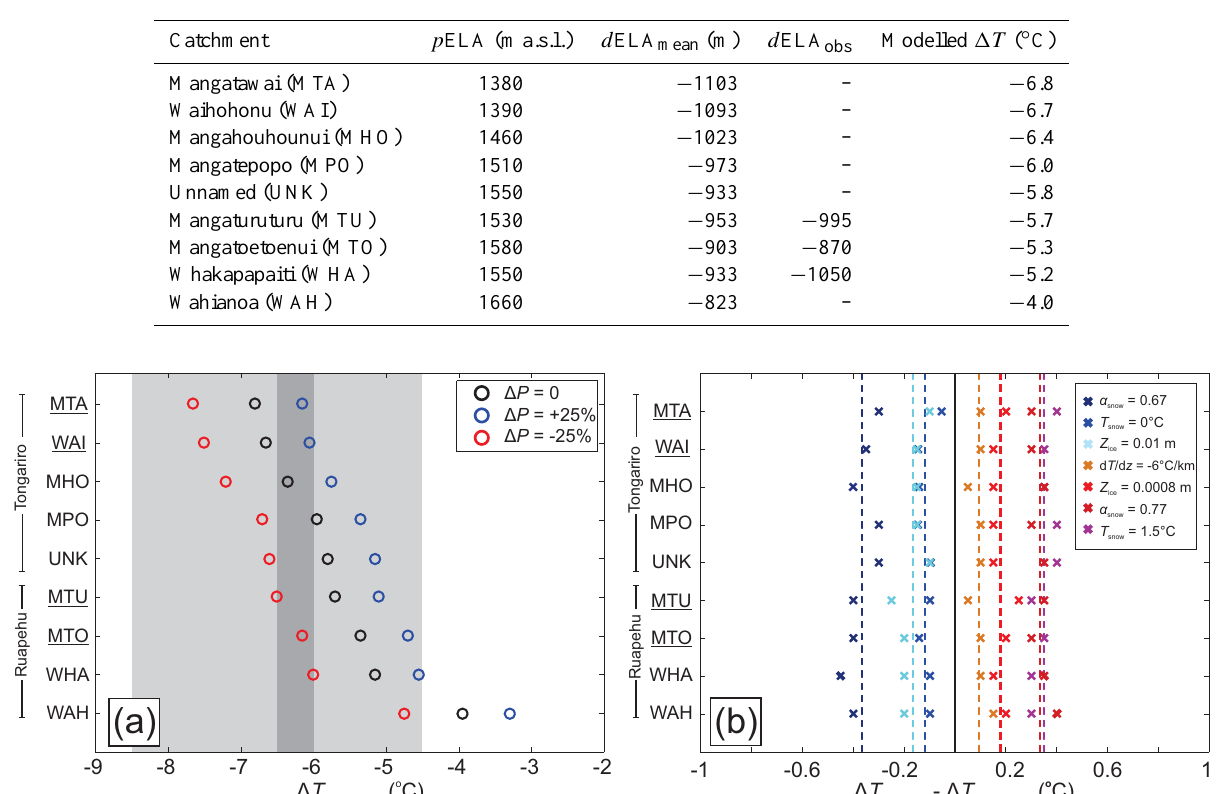
Table 3. Palaeo-equilibrium line altitudes ( p ELA) of the simulated LGM glaciers and the difference from present using ( d ELA mean (m): arithmetic mean of Keys (1988), 2483ma.s.l.; d ELA obs : change from the mid-point of observed present-day ELAs of individual glaciers given by Keys (1988), where available (see Table 1).